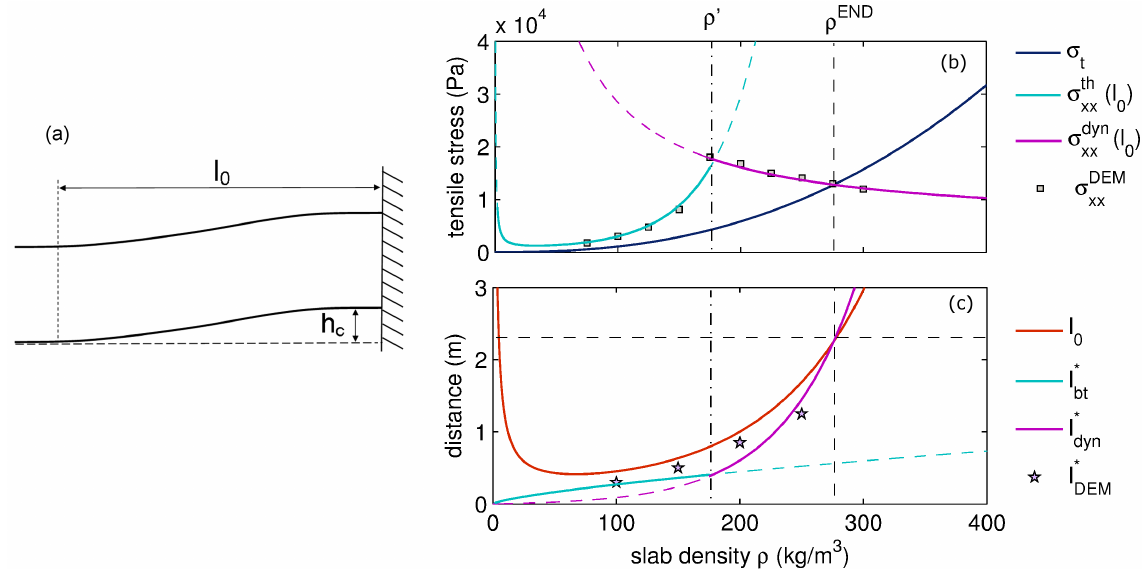
Figure 15. (a) Illustration of the characteristic length l 0 required for the slab to be in contact with the broken WL. h c represents the collapse height. (b) Maximum tensile stress σ m xx as a function of slab density for the discrete element model σ DEM xx , with a purely elastic slab and case #1, according to beam theory σ th xx (l 0 ) and from an empirical (exponential) fit σ dyn xx (l 0 ) . The tensile strength of the slab σ t is also represented as a function of slab density ρ . (c) Propagation distance for the same cases as in (b) plus l 0 as a function of slab